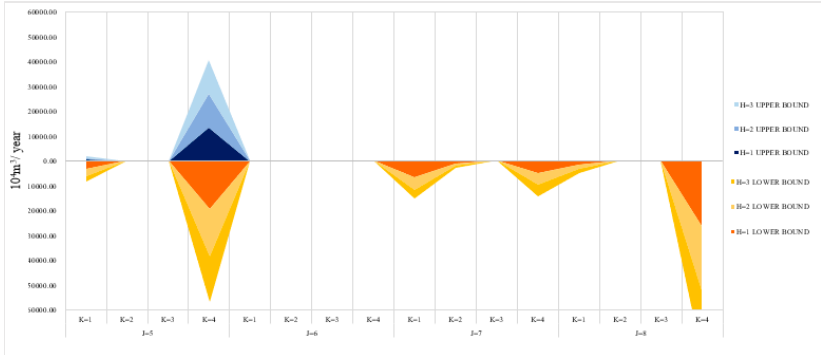
Figure 13. Water shortage in different water use departments in different situations in the third planning period.